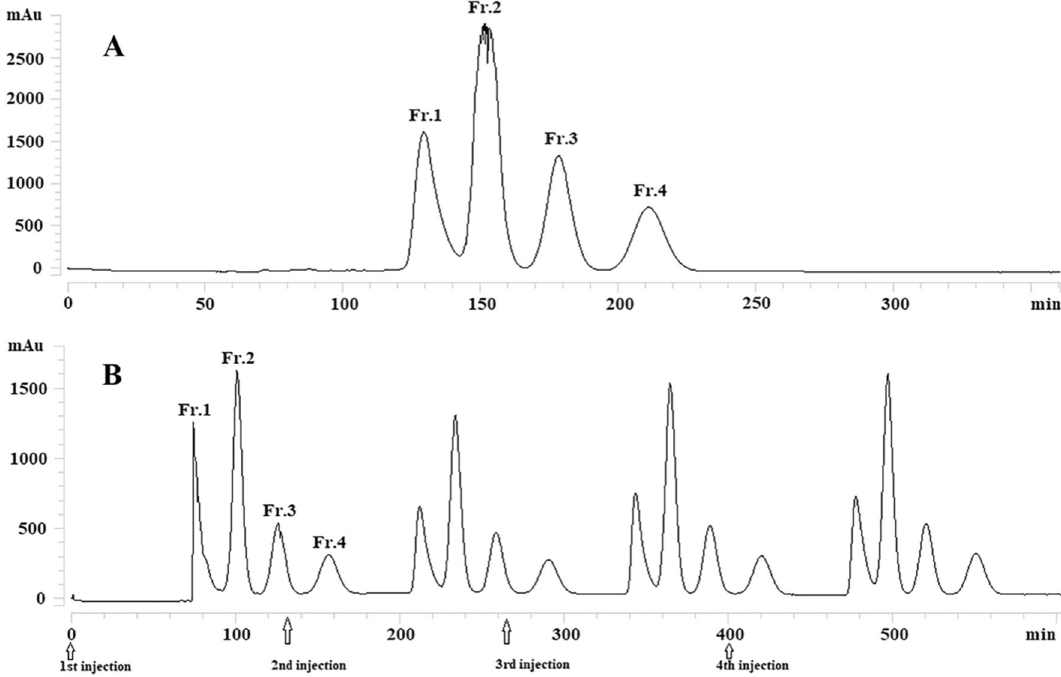
Figure 1. HSCCC chromatogram of 40% methanol fraction using n-hexane–ethyl acetate–methanol–water (3:5:3:5, v/v) (1.5% acetic acid). Conditions: stationary phase, upper phase; revolution speed, 800 rpm; separation temperature, 30 °C; detection wavelength, 320 nm; flow rate, 2.0 ml/min ( A : Single injection; B : forth continuous sample